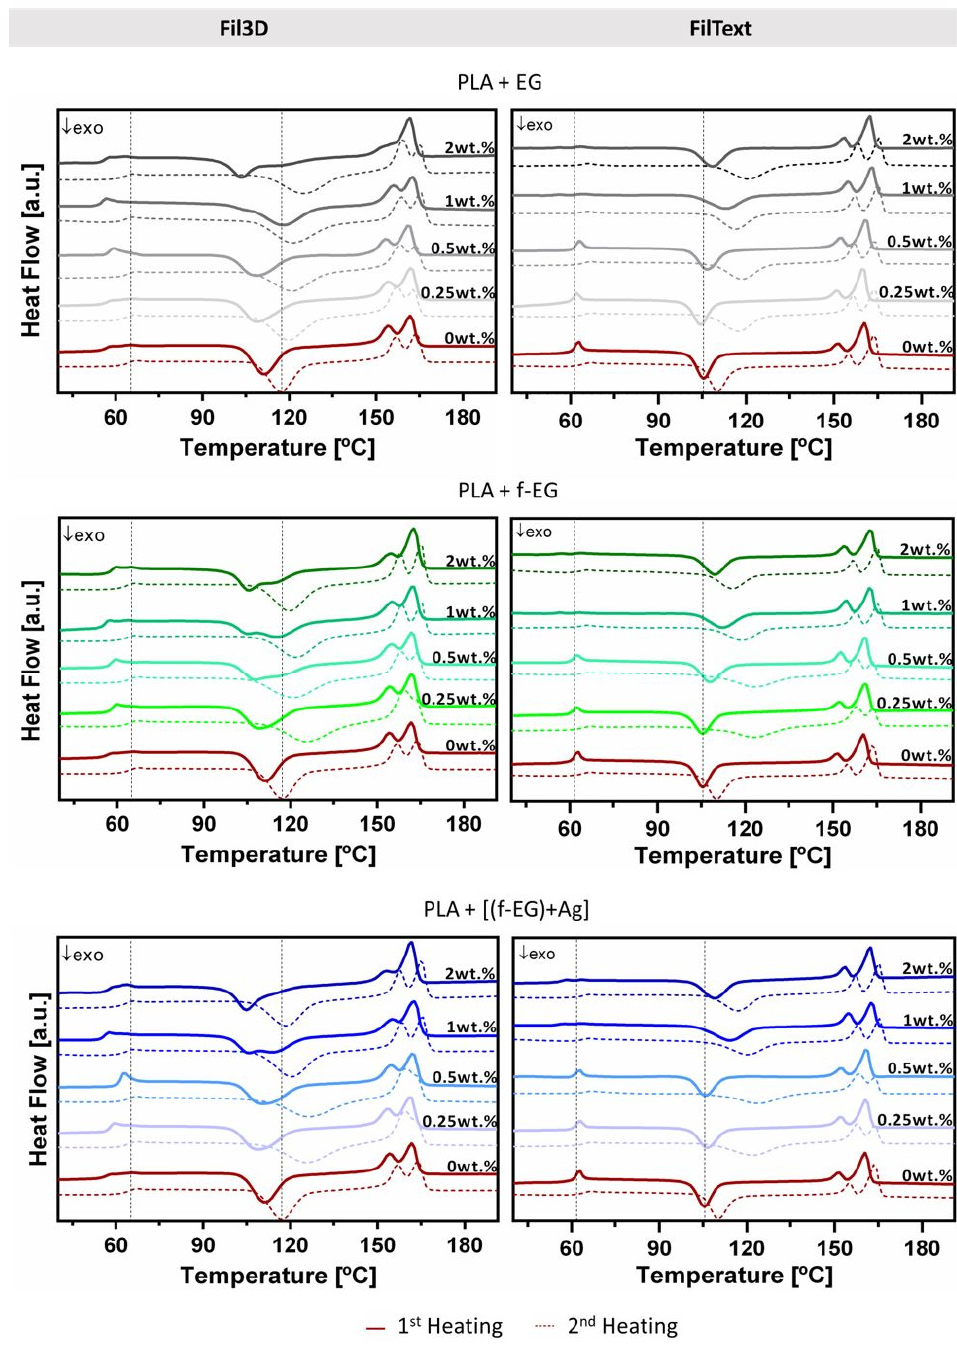
Figure 13. DSC scans of Fil3D and FilText, namely first and second heating, represented by continuous and dashed lines, respectively. Black dashed vertical lines mark the T g and T c of PLA during the second heating scan of Fil3D and first heating scan of FilText.